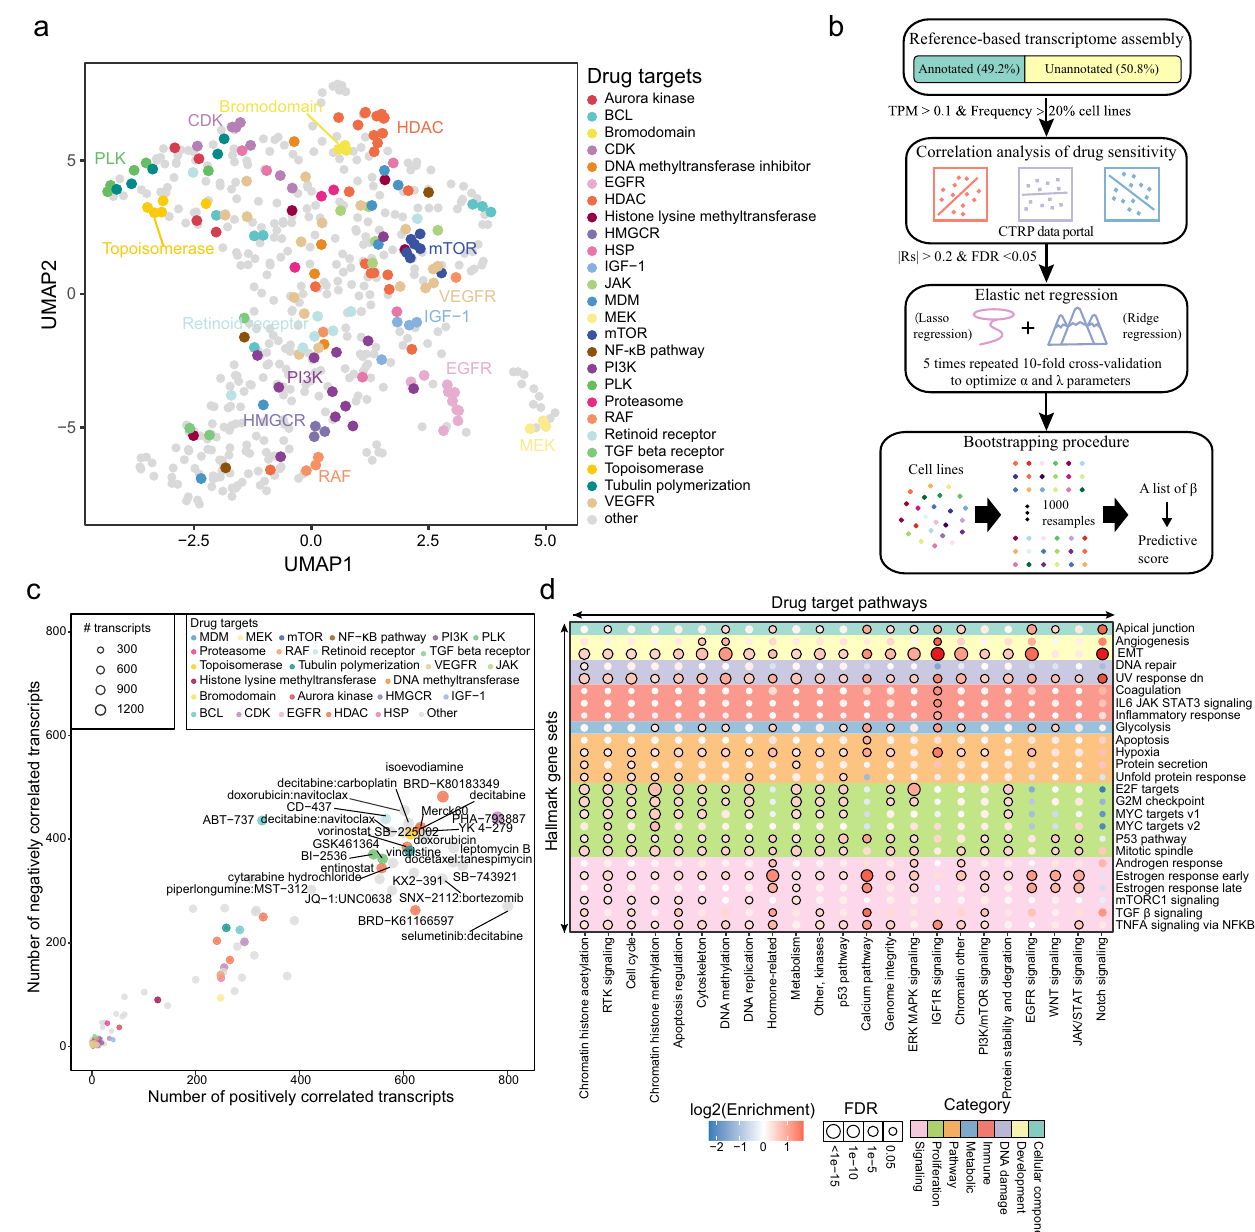
Fig. 4 | Associations between transcript expression and anti-cancer drug sensitivity. a UMAP shows the drug groups clustered by associated transcripts. b Work fl owof identifyingdrug-associatedtranscriptsbased onamachine learning model. c Thescatterplotshowsthenumbersofpositivelyandnegativelyassociated transcripts for each anti-cancer drug (predictive score ≥ 0.7). d The bubble plot